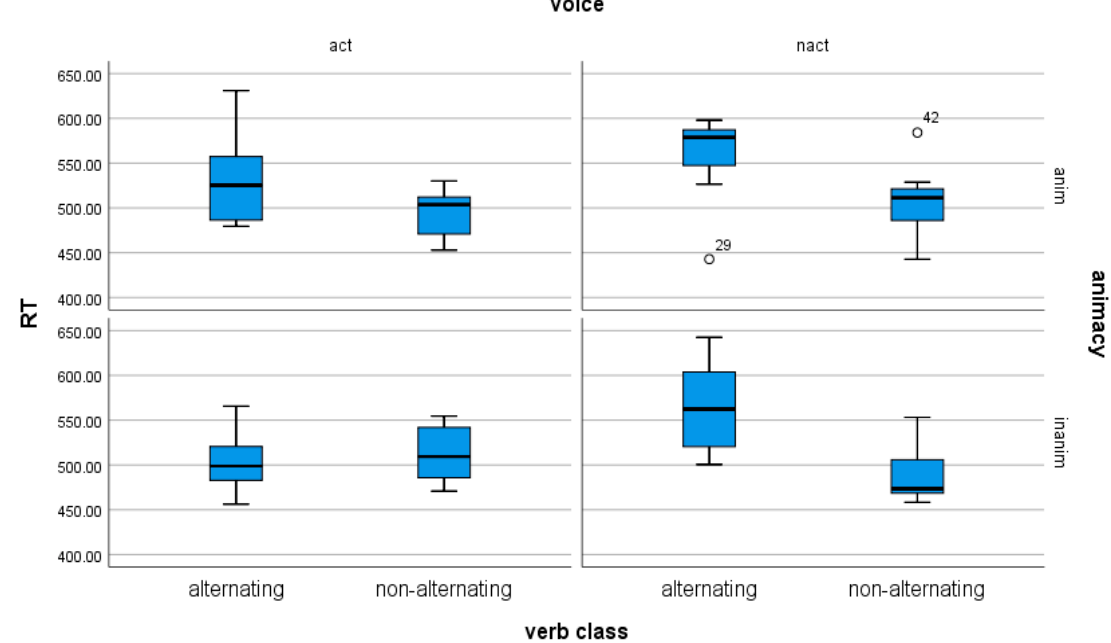
Figure 3. Hi-low RTs on the fourth segment (by voice, animacy and verb class). Turning to a more fine-grained-level analysis, we examine the processing of individual verbs (considering subject animacy in the two available ACT-NACT markings). Verbs revealed different patterns: Among ‘voice non-alternating’ anticausatives (Figure 4a), for steg- noni (dry), the main effects of voice or animacy were not significant across segments, though on the verb (third) segment a significant interaction of voice by animacy (F(1,41) = 4.087, p = 0.05) is attributed to shorter time needed to read NACT types when preceded by inanimate than animate subjects (t(41) = 2.099, p = 0.042), but no such difference arose for ACT types. The verb vrazi (boil) revealed no significant effects throughout sentence processing. In sapizi (rot), a significant voice effect was found on the third (F(1,41) = 10.080, p = 0.003) and fourth segments (F(1,41) = 5.212, p = 0.028), while a significant interaction of voice by animacy was found on the seventh segment (F(1,41) =6.788, p = 0.013), which owes its manifestation to faster reading times for NACT types with animate than inanimate subjects (t(41) = 2.390, p = 0.022), but no such difference was attested for ACT types. In lioni (melt), the voice effect was not significant on the critical third verb segment but on the following one, i.e., on the fourth segment (F(1,41) = 9.393, p = 0.004) only. In lijizi (bend), we also found a significant voice effect on the third (F(1,41) = 5.628, p = 0.022) and fourth segments (F(1,41) = 10.080, p = 0.003), while a significant interaction of voice by animacy was registered on the following segments, i.e., on the fifth (F(1,41) = 5.548, p = 0.023) and sixth (F(1,41) = 10.196, p = 0.003): sentences with NACT types were read faster when preceded by animate than inanimate subjects on both the fifth (t(41) = 2.739, p = 0.023) and sixth segments (t(41) = 2.037, p = 0.048), while no such differences were found for sentences with ACT types. In klini (close) no significant effects were found throughout the whole sentence. Finally, in jerni (lean), a significant voice effect was first evidenced on the third segment (F(1,41) = 4.072, p = 0.05) and remained significant on the fourth (F(1,41) = 5.718, p = 0.021), marginal on the fifth (F(1,41) = 3.914, p = 0.055) and regained strength on the seventh segment (F(1,41) = 4.728, p =